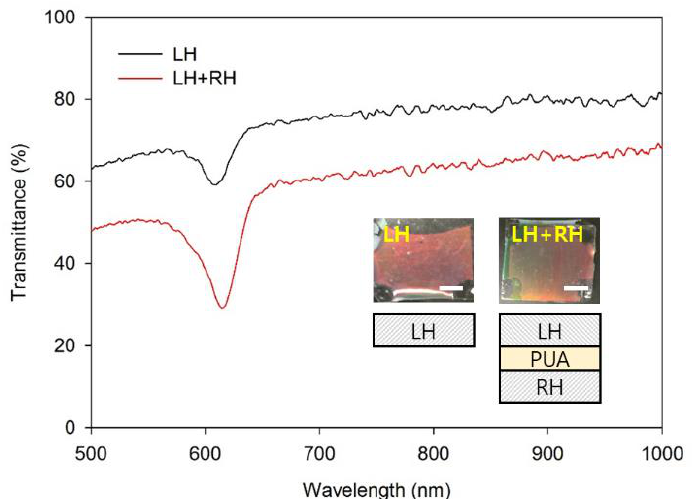
Figure 4. The optical characteristics of the CLC-PUA composite films. Transmittance spectra of CLC-PUA composite films with a LH CLC template (black line) and a stack of LH and RH CLC templates (red line). Insets show the optical image of the CLC-PUA composite film with a LH CLC template (left) and a stack of LH and RH CLC templates (right) with their schematic descriptions. Scale bares are 200 μm.